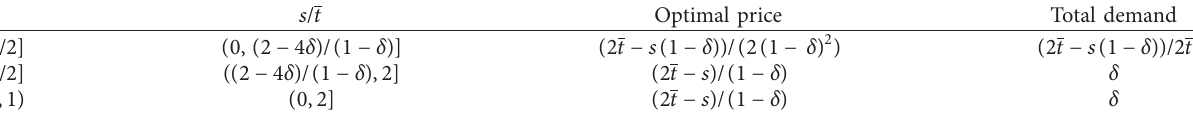
Table 1: The optimal price, demand, and profit in the benchmark model.